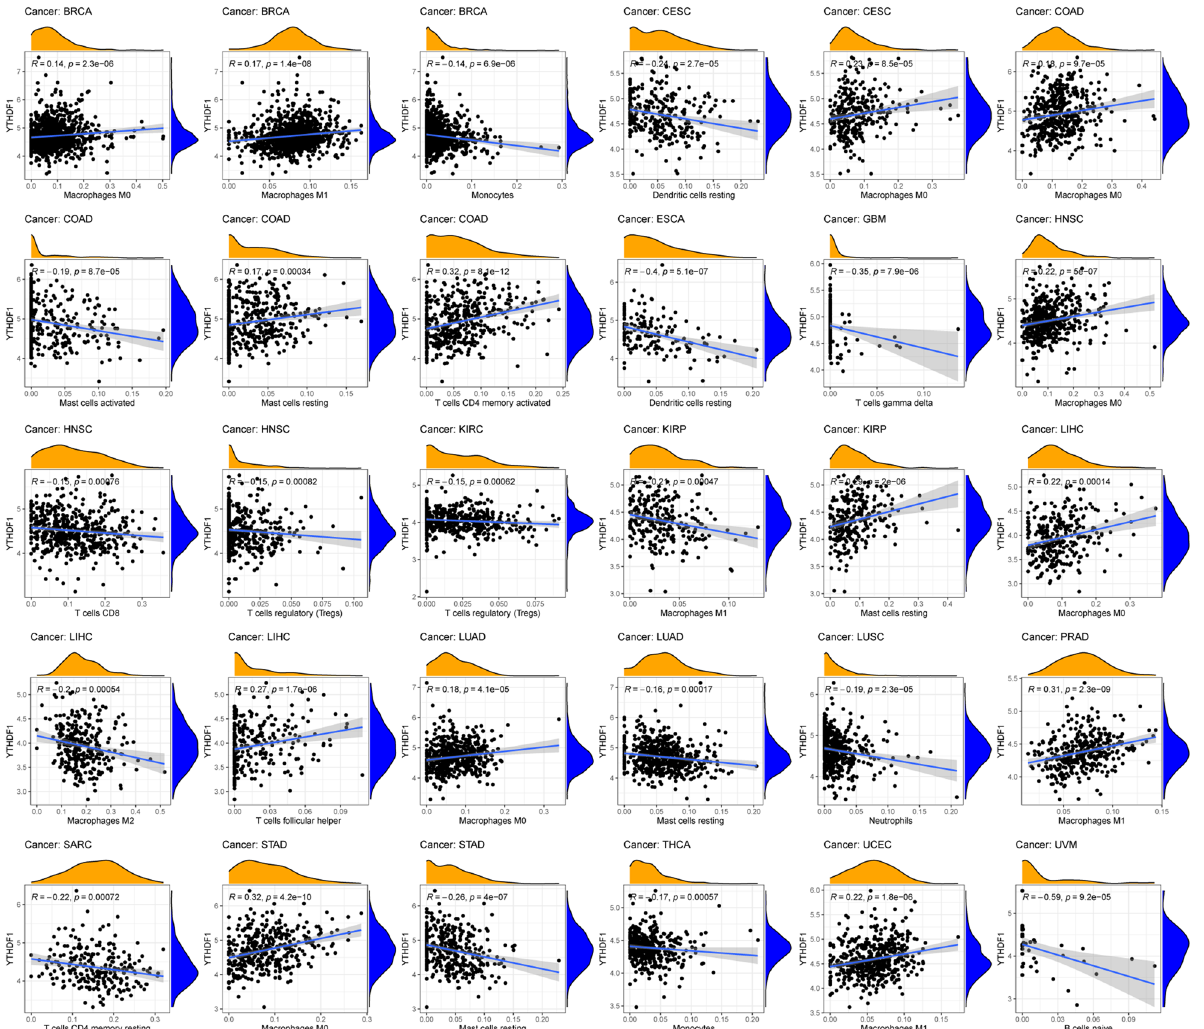
Figure 10. Correlation between YTHDF1 expression and immune cell infiltration in